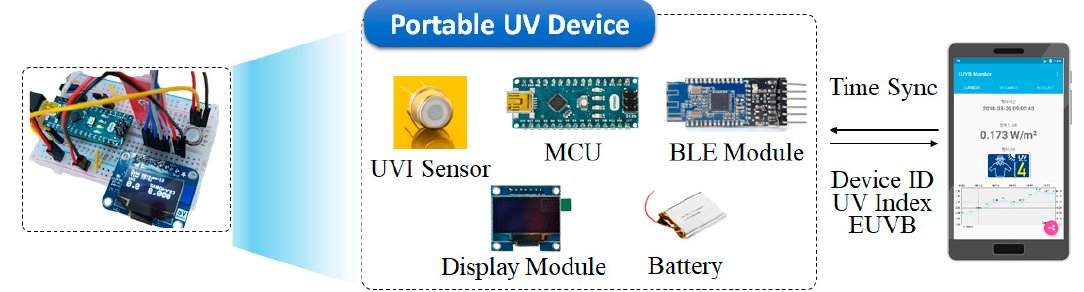
Figure 3. Portable measurement device and smartphone application. UVI: UV index; MCU: micro controller unit; BLE: Bluetooth Low Energy.